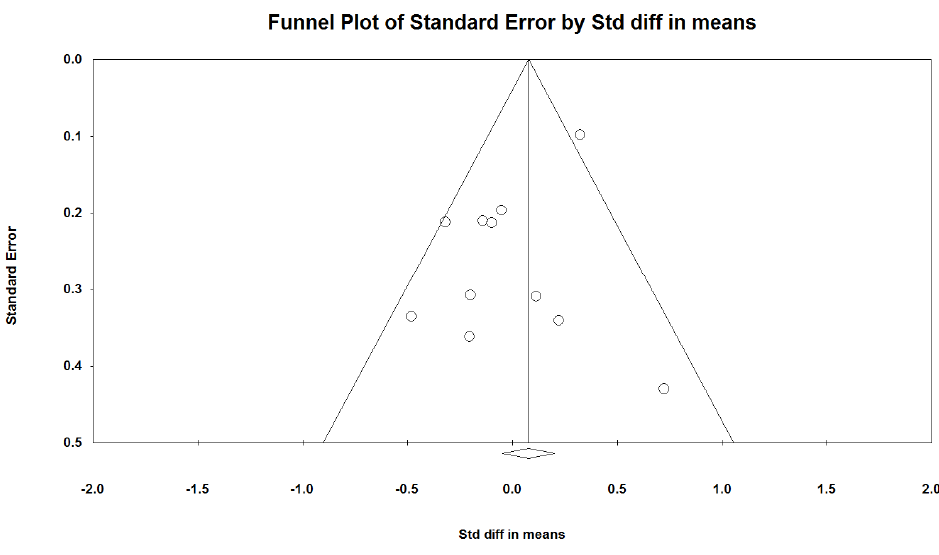
Figure 3. Funnel plot.